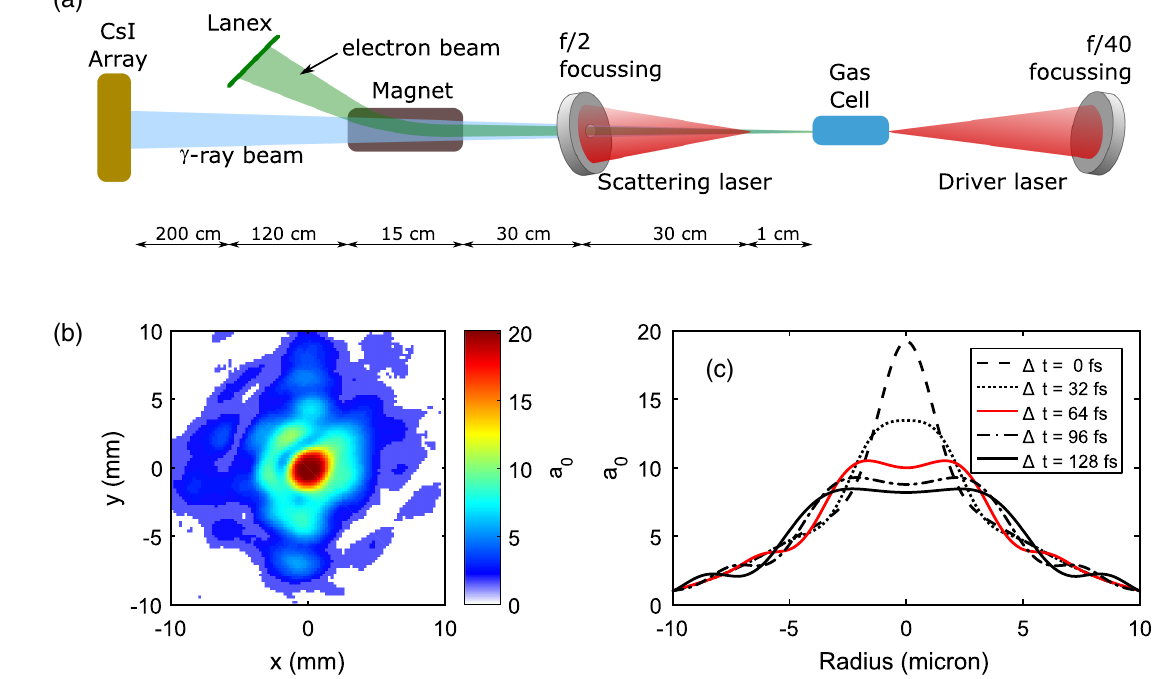
FIG. 1. Experimental setup. (a) Schematic of the experimental setup (not to scale). See details in the text. (b) Typical measured spatial distribution of the intensity in focus of the scattering laser beam. (c) Computed transverse distribution of the normalized laser field amplitude of the scattering laser at the overlap point as a function of